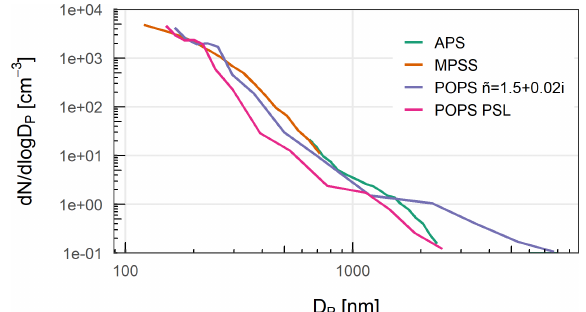
Figure 9. Mean particle number size distribution (PNSD) of POPS when CAMP was on the ground compared with MPSS and APS over a 20min scanning period in Melpitz on 15 February 2019. The PSL-calibrated optical PNSD from the POPS was corrected for best fit with an assumed aerosol refractive index of ˜ n = 1 . 5 + 0 . 02 i